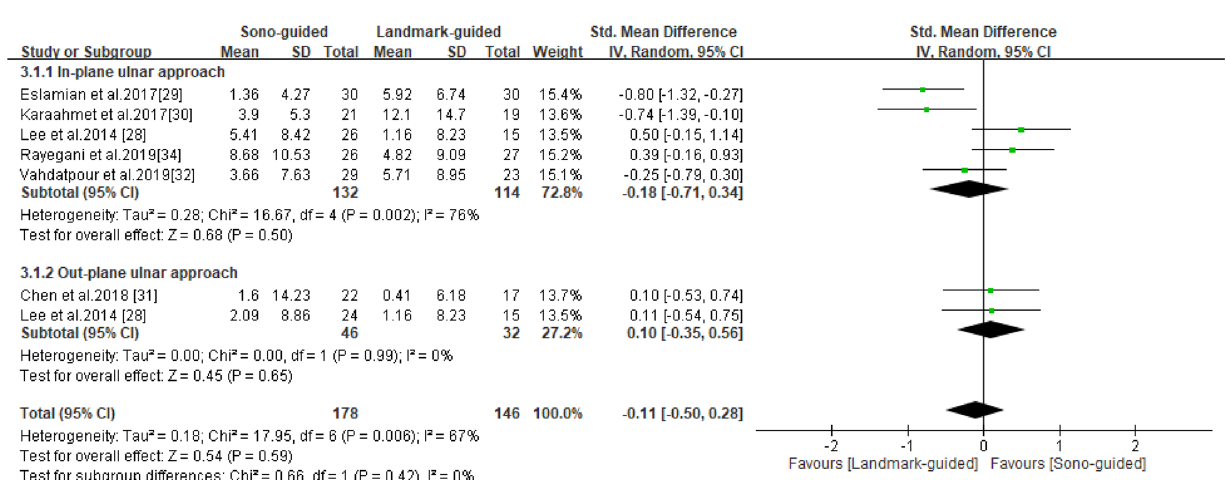
Figure 4. Forest plot for BCTQ-FSS. US-guided, ultrasound-guided; LM-guided, landmark-guided.